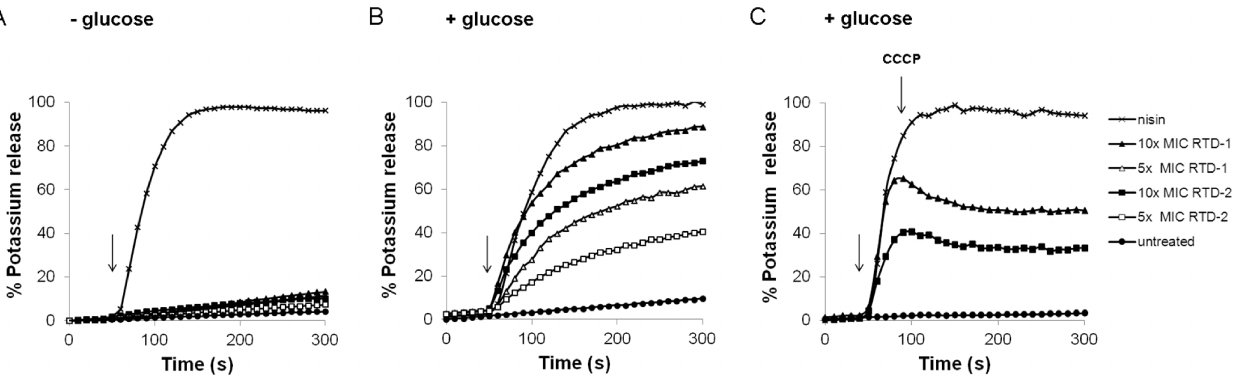
Figure 3. Impact on the membrane integrity of RTD-treated S. simulans 22 cells. Potassium efflux was monitored with a potassium-sensitive electrode in absence (A) and presence (B) of 10 mM glucose. RTD-induced potassium release of energized cells could be blocked by the addition of 5 µM CCCP (carbonyl cyanide m-chlorophenylhydrazone; (C). Ion leakage was expressed relative to the total amount of potassium released after addition of 1 µM of the pore-forming lantibiotic nisin (100% efflux). RTDs were added at 5× and 10× MIC; controls were incubated without peptide. The arrows indicate the moment of peptide